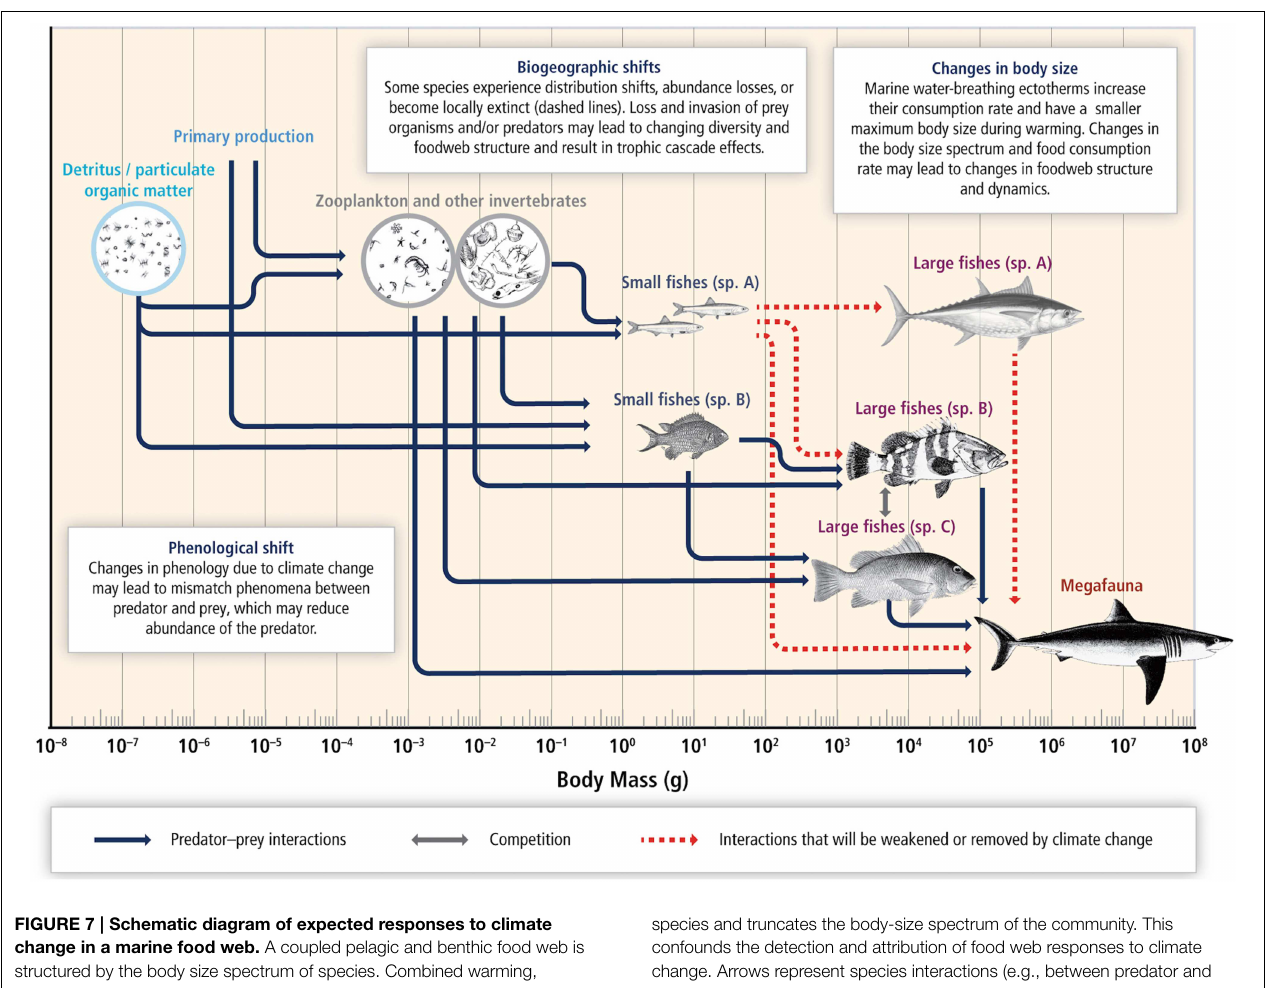
FIGURE 7 | Schematic diagram of expected responses to climate change in a marine food web. A coupled pelagic and benthic food web is structured by the body size spectrum of species. Combined warming, hypoxia, and ocean acidification reduce body size, shift biogeographies, change species composition and abundance, and reconfigure trophic linkages and interaction dynamics. Fishing generally removes large-bodied